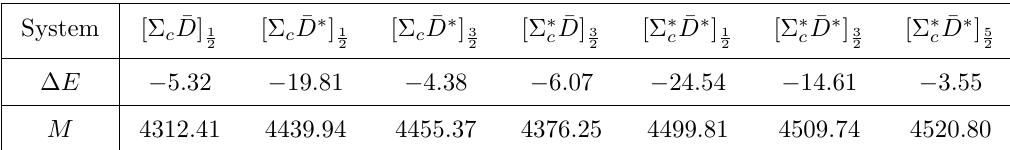
hidden-charm [(cid:6) ( (cid:3) ) c (cid:22) D ( (cid:3) ) ] J systems in the 2